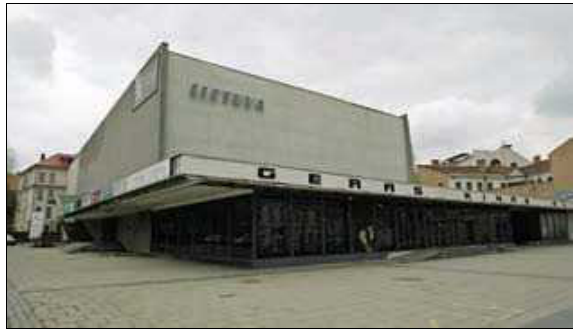
Fig. 20. cinema “Lietu­va“ in Vilniu­s (arch. J.